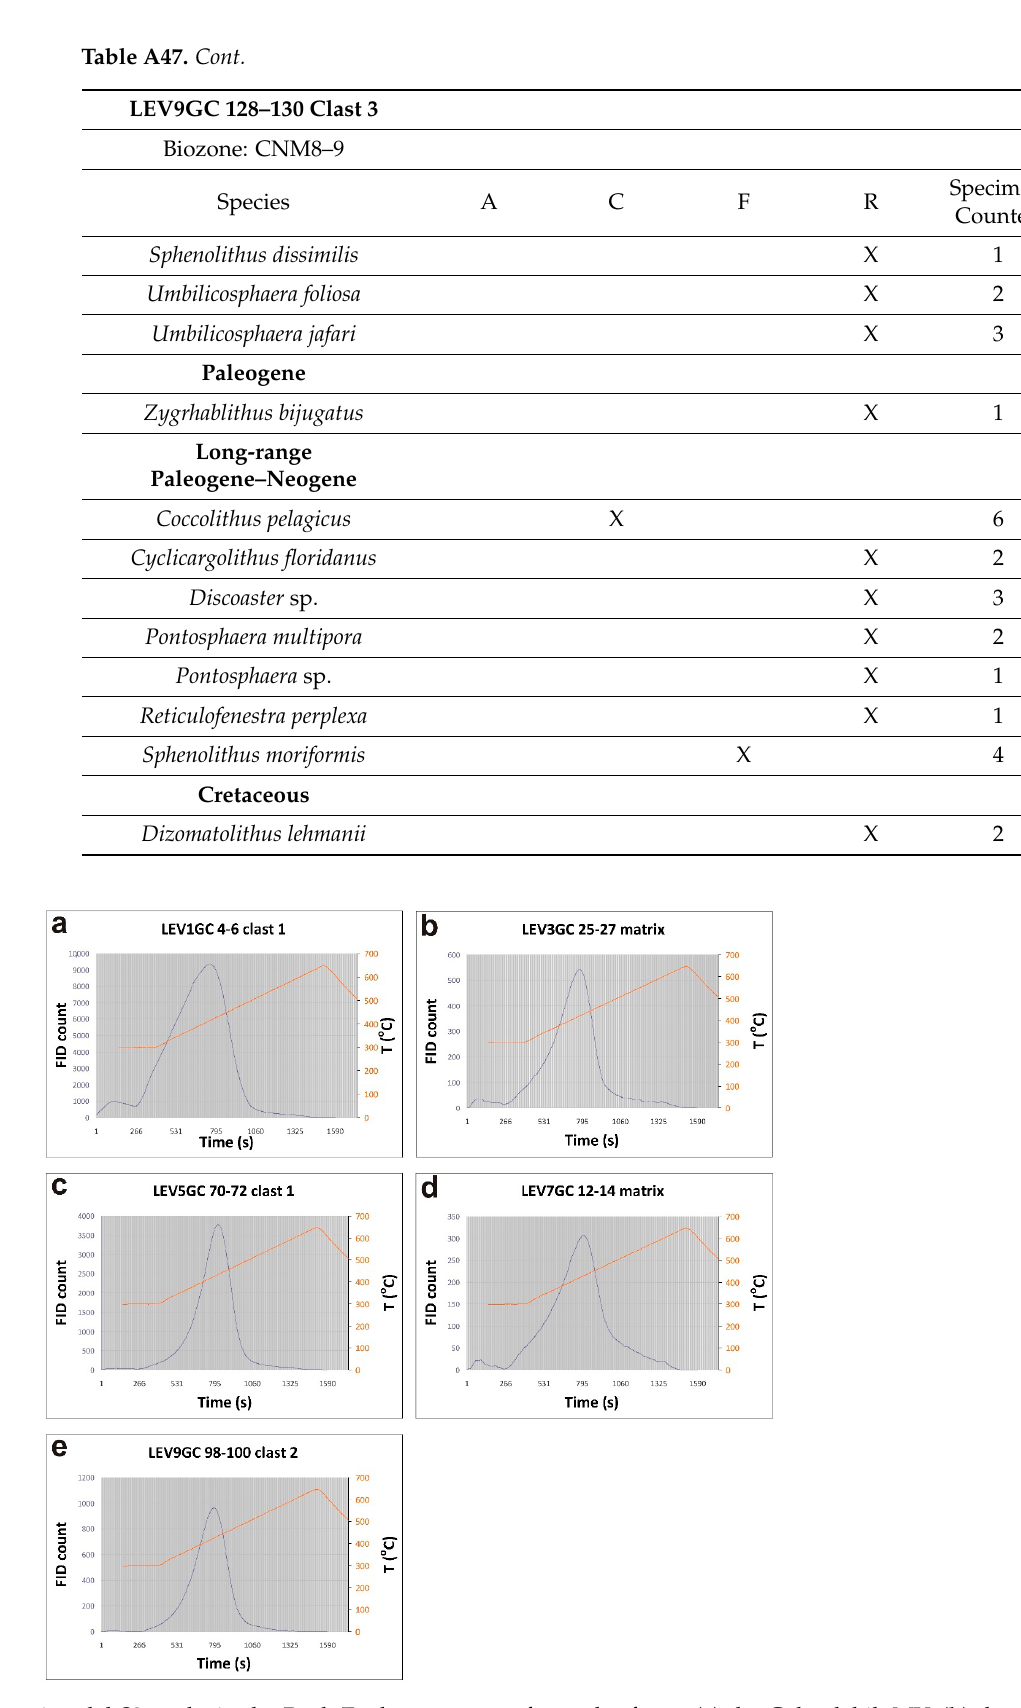
Figure A1. Distinct unimodal S2 peaks in the Rock-Eval pyrograms of samples from: ( a ) the Gelendzhik MV, ( b ) the Heraklion MV, ( c ) the Moscow MV, ( d ) the Milano MV, and ( e ) the Leipzig MV.